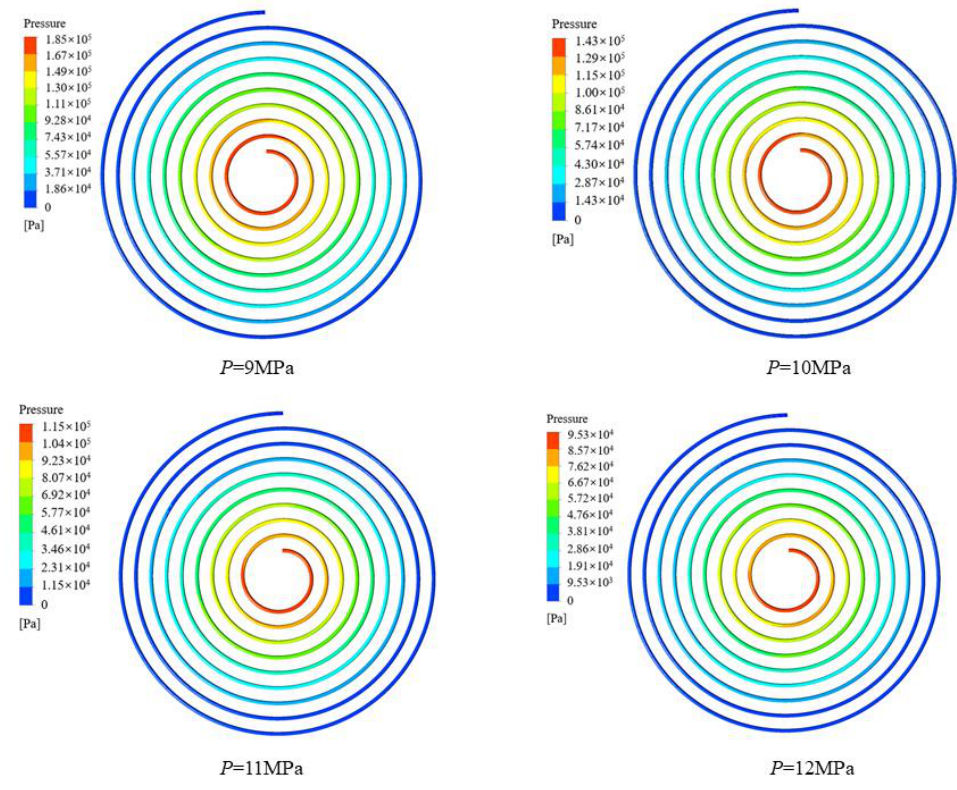
Figure 12. Variation in the pressure contour of CO 2 at different cooling pressures.